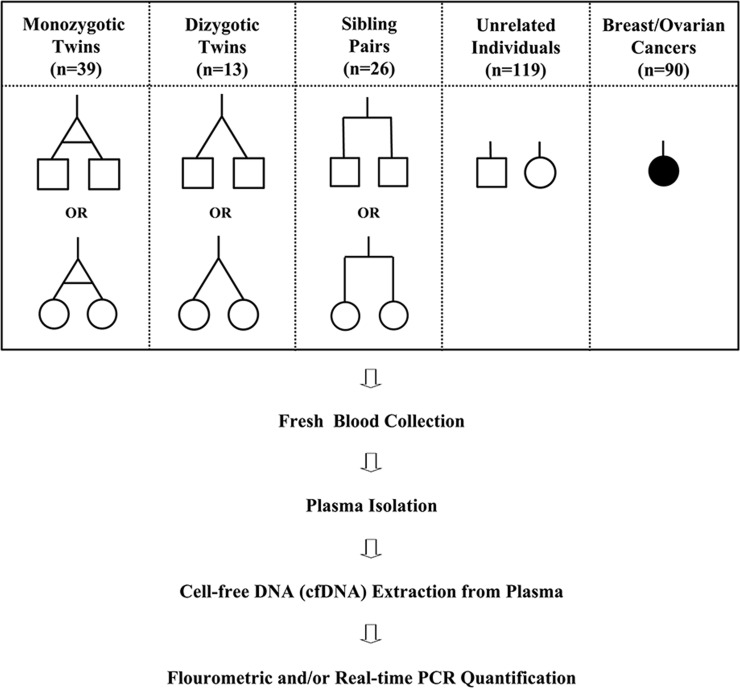
Study design and blood sample collection.The schematic illustration of experimental design showing blood sample collection from healthy individuals and cancer patients, and cell-free DNA (cfDNA) quantification steps. A total of 275 fresh blood samples were collected from monozygotic (n = 39) twins, dizygotic (n = 13) twins, sibling pairs (n = 26), genetically unrelated healthy individuals (n = 119), and a total of 90 blood samples from breast (n = 26) and ovarian cancer (n = 64) patients. Plasma was isolated from a fresh blood sample then cfDNA was extracted from plasma and quantified by a fluorometer (ng/ml) and/or by real-time quantitative PCR (copies/ml).